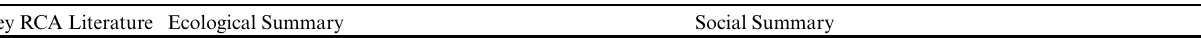
Table 5 . Summary of the key literature on social and ecological impacts of Rockfish Conservation Areas (RCAs). See Appendix 1 for a more in-depth